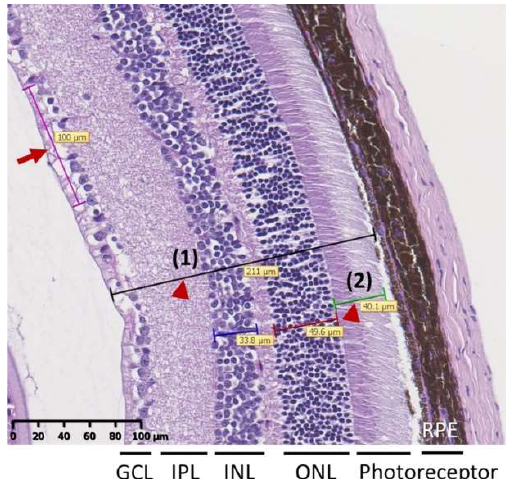
Figure 6. Representative image of retina for measurement of total retina thickness [indicated by arrow head (1)] and thickness of photoreceptor layer [(indicated by arrow head (2)]. Cell number per 100 μm of the GCL was counted based on the linear cell density (arrow). Data were presented as mean ± SD and were measured three times in each hemisphere.